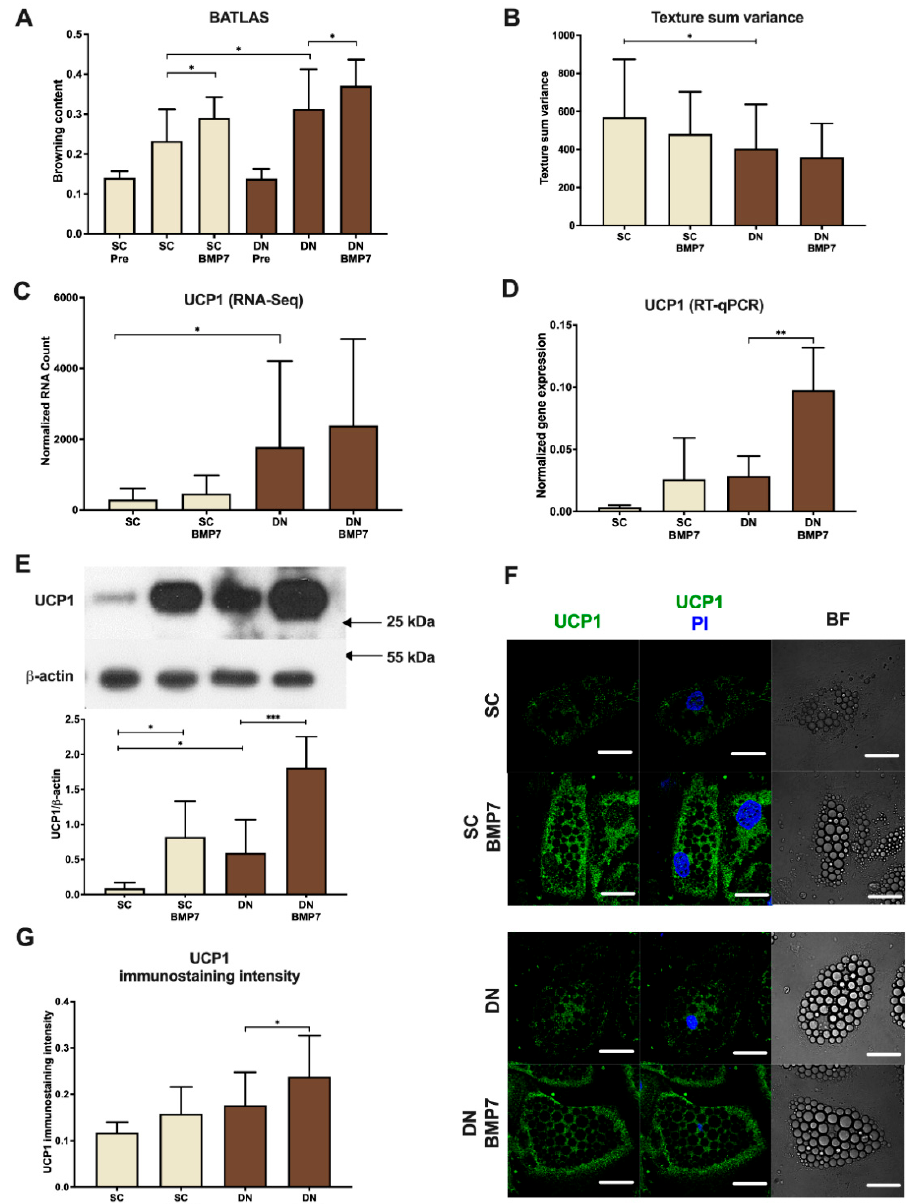
Figure 2. BMP7 upregulated browning markers in both SC and DN derived differentiated adipocytes. SC and DN preadipocytes were differentiated and treated as in Figure 1. ( A ) Browning content as estimated by BATLAS Webtool ( n = 9); ( B ) texture sum variance as quantified by laser-scanning cytometry ( n = 5); quantification of UCP1 gene expression by ( C ) RNA-sequencing ( n = 9) and ( D ) RT-qPCR normalized to GAPDH ( n = 5). ( E ) UCP1 protein expression normalized to β -actin ( n = 5); ( F ) representative UCP1 immunostaining images visualized by confocal microscopy. Nucleus was stained using propidium iodide (PI), BF represents bright field image. Scale bars represent 10 μ m. ( G ) Quantification of UCP1 immunostaining intensity assisted by laser-scanning cytometry ( n = 4000 cells of 4 donors). Data expressed as mean ± SD. * p < 0.05, ** p < 0.01, *** p < 0.001. Statistics: Paired t -test ( A , B , G ), GLM ( C ), and one-way ANOVA with Tukey’s post-test ( D , E ).